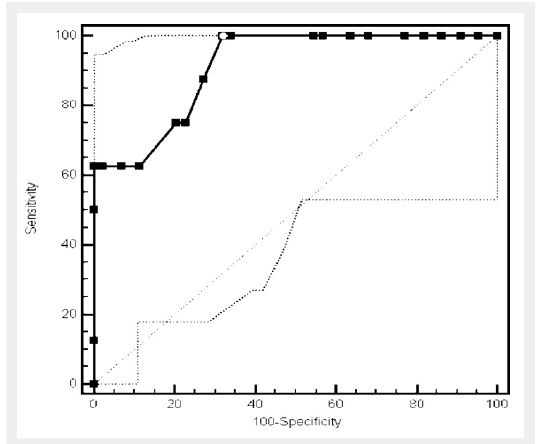
Receiver operating characteristic (ROC) curve for prediction of early hypoparathyroidism using intraoperative rapid PTH assay. Area under the curve (AUC) = 0.912 (SE = 0.05, 95% CI = 0.8 – 0.973, P < 0.0001). White dot along the curve represents optimal cutoff value (PTH < 27 pg/ml). This had sensitivity of 100% (95% CI = 63.1% – 100%), specificity of 68.2% (95% CI = 52.4% – 81.4%, LR+ of 3.1 (95% CI = 2.6 – 3.8), LR– of 0, PPV of 36.4% (95% CI = 17.2% – 59.3%), and NPV of 100.0% (95% CI = 88.1% –